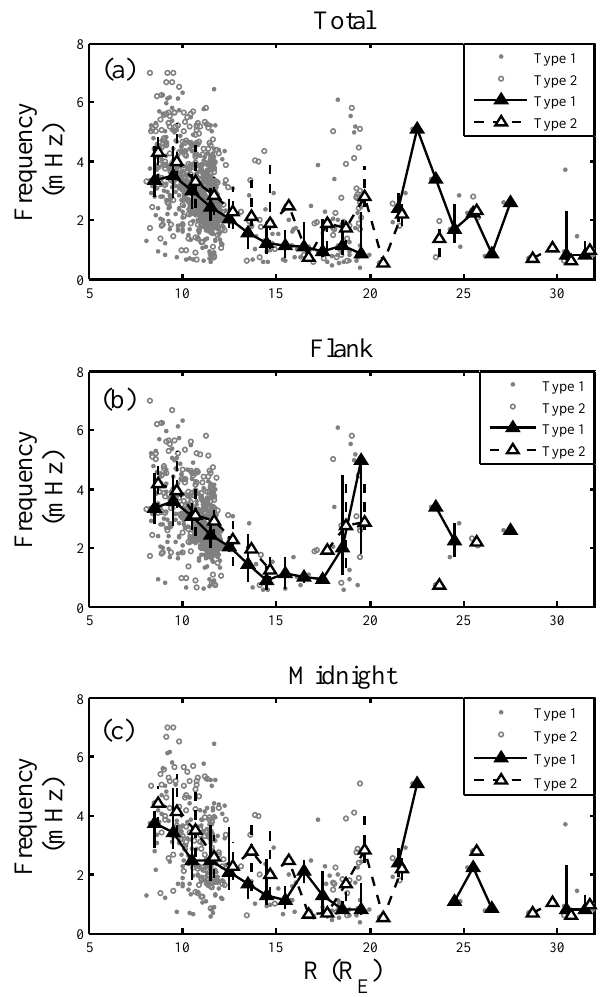
Figure 9. The wave frequency versus the distance from Earth for (a) the type one and type two wave events, (b) the wave events in the flank region, and (c) the wave events in the midnight region, respectively. The grey dots and circles indicate type one and type two wave individual events, respectively. The solid and open trian- gles are the median values of frequencies in each 1 R E bin for the type one and type two wave events, respectively. The vertical bars connect the lower and upper quartiles for each